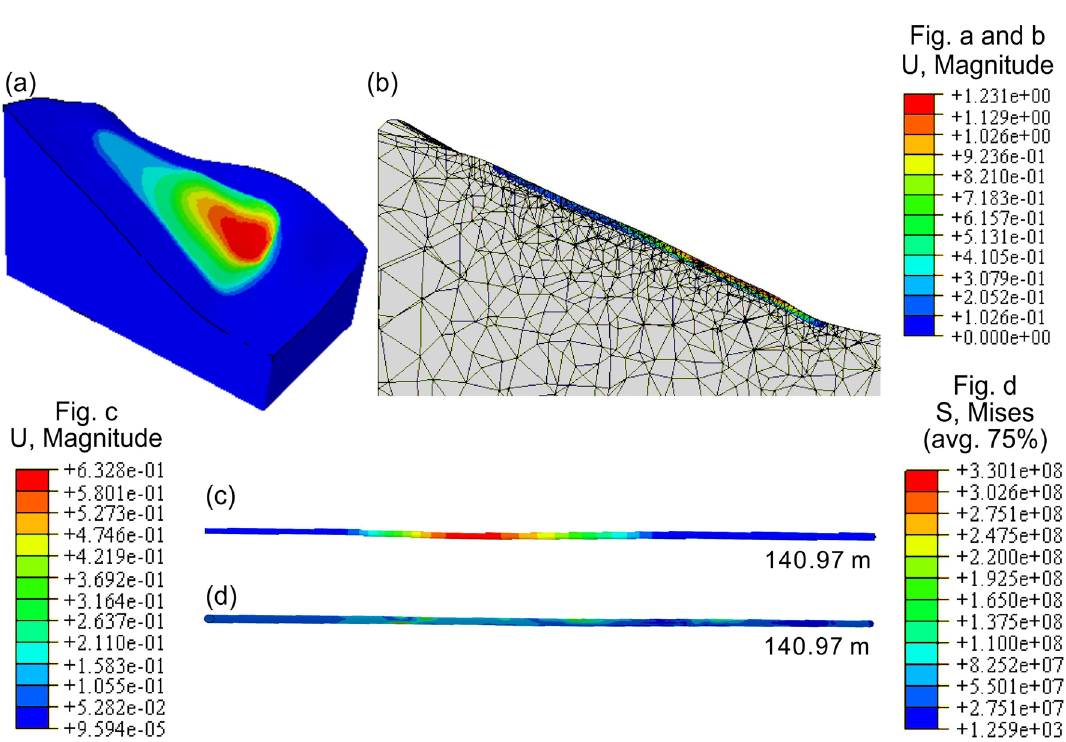
Fig. 11 Simulation results for the most dangerous landslide where pipeline stress is at the critical value. a Slope displacement; b slope profile displacement; c pipeline displacement; d pipeline